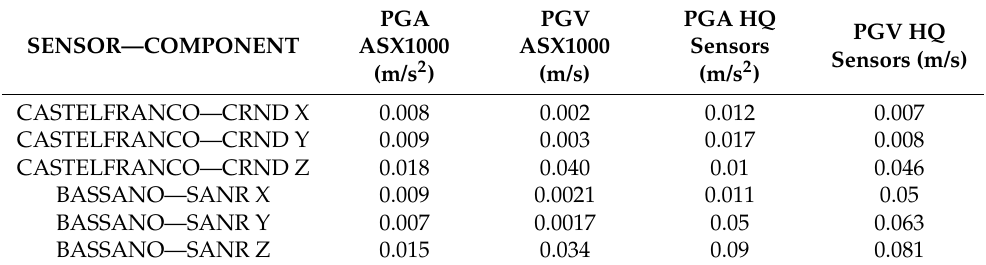
Table 2. PGA and PGV values recorded by the ASX1000 prototypes and the high-quality seismic sensors.